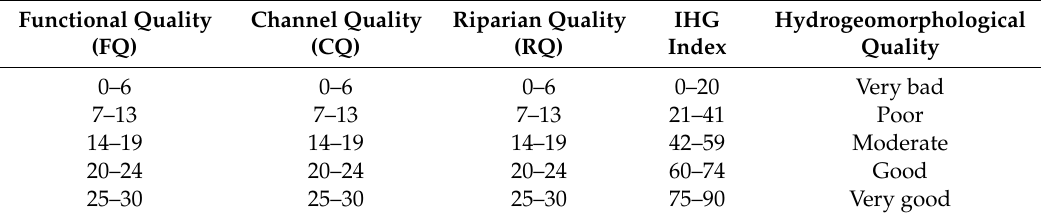
Table 3. Total and partial scores for each section (Functional Quality (FQ), Channel Quality (CQ), and Riparian Quality (RQ)) of the Hydrogeomorphological Index (IHG) index and hydrogeomo- rphological quality classes.